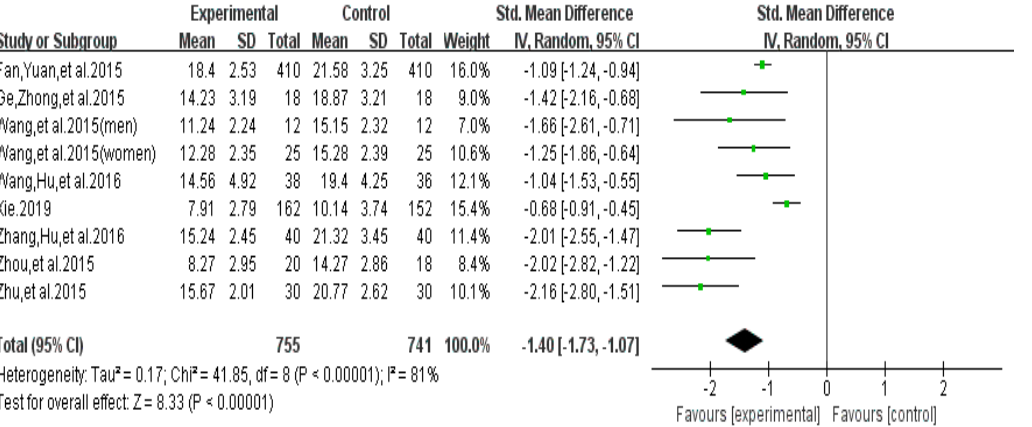
Figure 4. Funnel plot for publication bias of withdrawal symptoms.